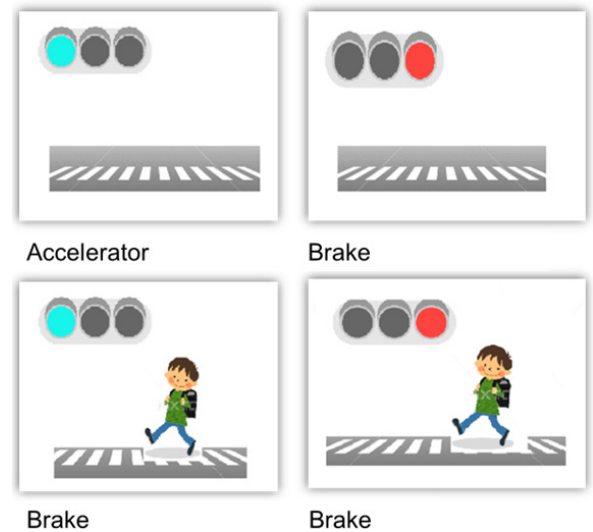
Figure 1. A computer designed for persons with a disability of the upper extremities was used, since this has two pedals placed side by side for use with the lower extremities. Each participant sitting position was asked to press the “brake” or “accelerator” pedal as quickly as possible in response to a traffic situation indicated by each of four images shown on the